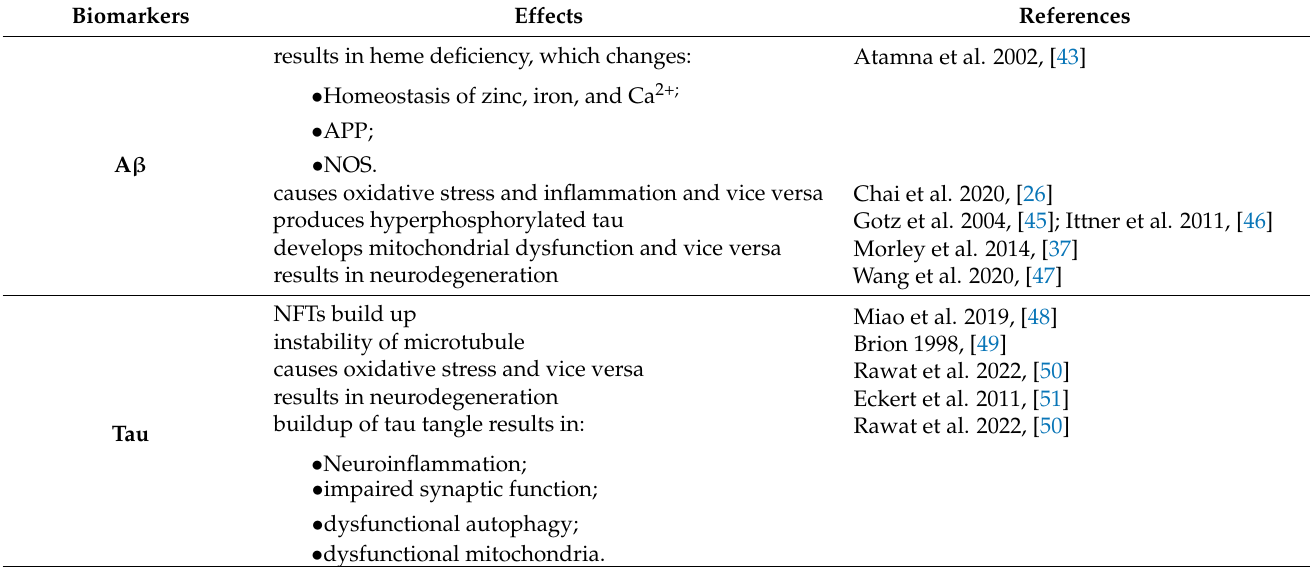
Table 1. A summary of the effects of tau and A β , two main players that are associated with the development of